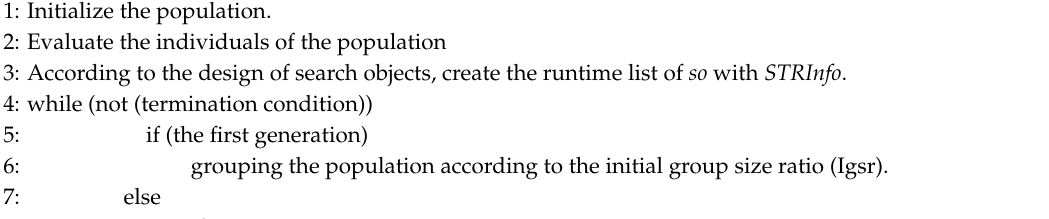
Algorithm 2. The algorithm of the